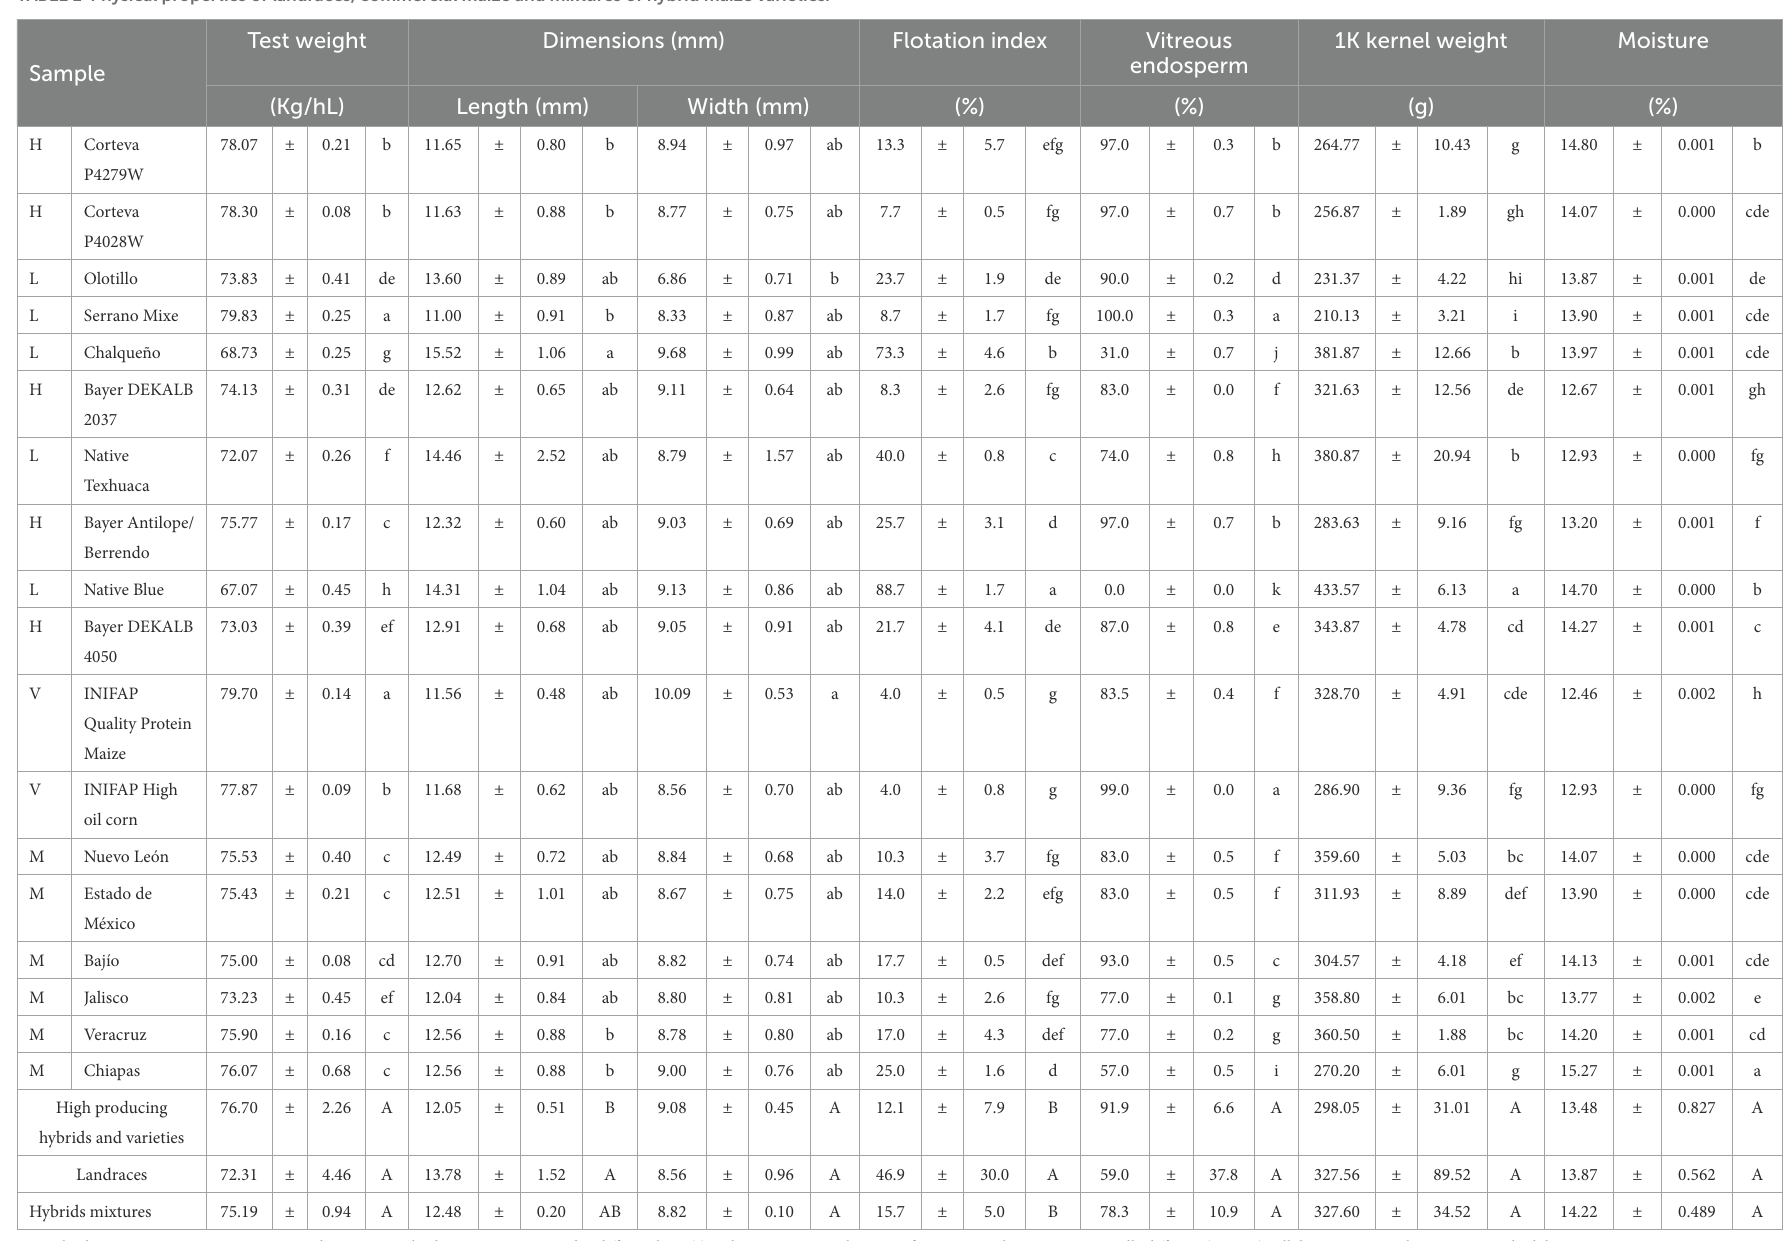
TABLE 1 Physical properties of landraces, commercial maize and mixtures of hybrid maize